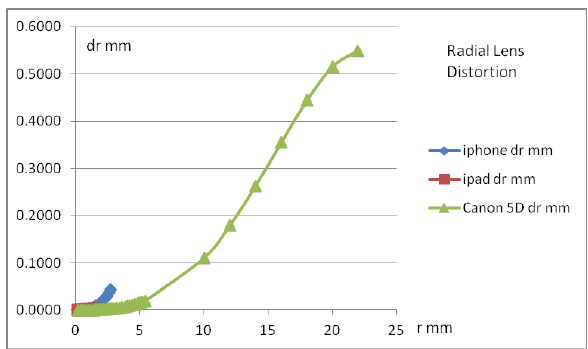
Figure 3. Radial lens distortion over the maximum radial distance of the iPhone